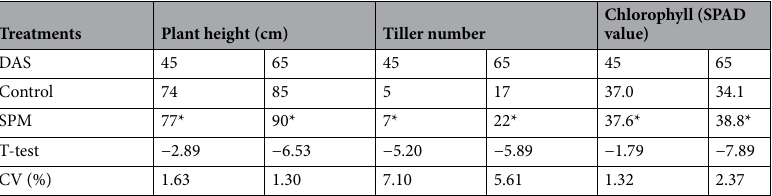
Table 2. Effect of spermine on plant height, tiller number and chlorophyll content in MADA at different days after sowing. T-test was performed at P ≤ 0.05. *: Significant at P ≤ 0.05. DAS: Days after sowing, SPM: spermine, MADA: Muda Agricultural Development Authority and CV: Coefficient of variation.